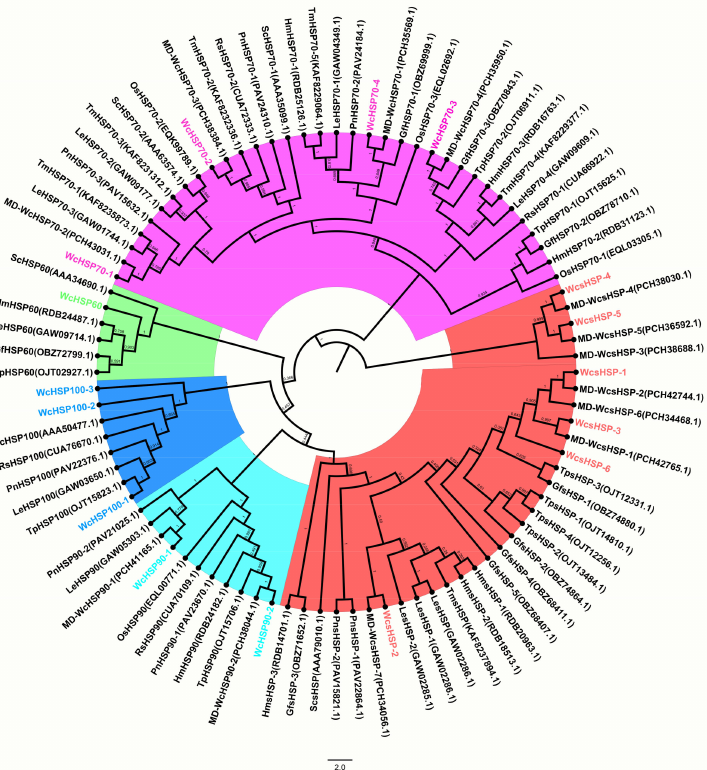
Figure 2. Phylogenetic analysis of heat shock proteins from different species. Different colors represent different subfamilies; red color denotes WcsHSP subgroup; green color denotes WcHSP60 subgroup; purple color denotes WcHSP70 subgroup; turquoise color denotes WcHSP90 subgroup and blue color denotes WcHSP100 subgroup. The numbers near the branches denote bootstrap